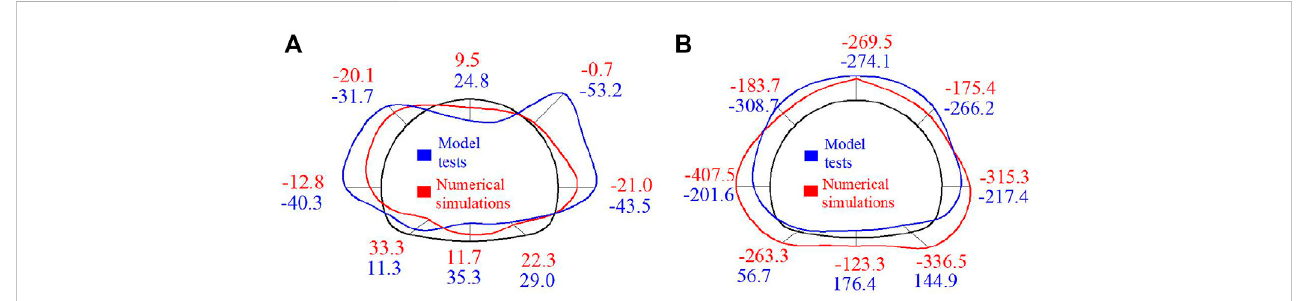
FIGURE 16 Structural internal forces in numerical simulations and model tests: (A) Bending moment of lining structure (unit: kNm) and (B) Axial force of lining structure (unit: kN).